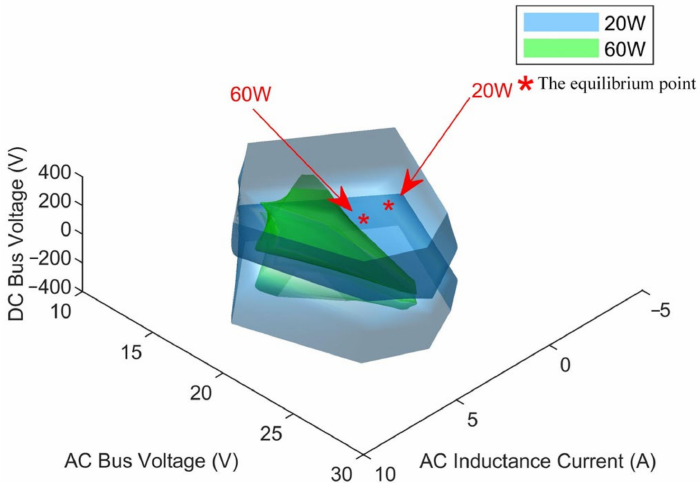
Figure 21. The 3D RAS of microgrids with the battery in charging mode (CPL power was 20 W and 60